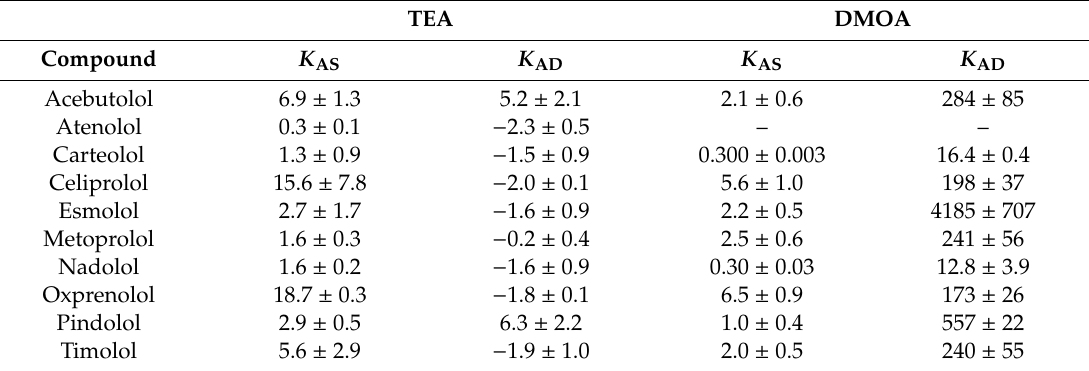
Table 4. Association constants between the solute and stationary phase ( K AS ) and between the solute and additive in the mobile phase ( K AD ) in the presence of amines. TEA